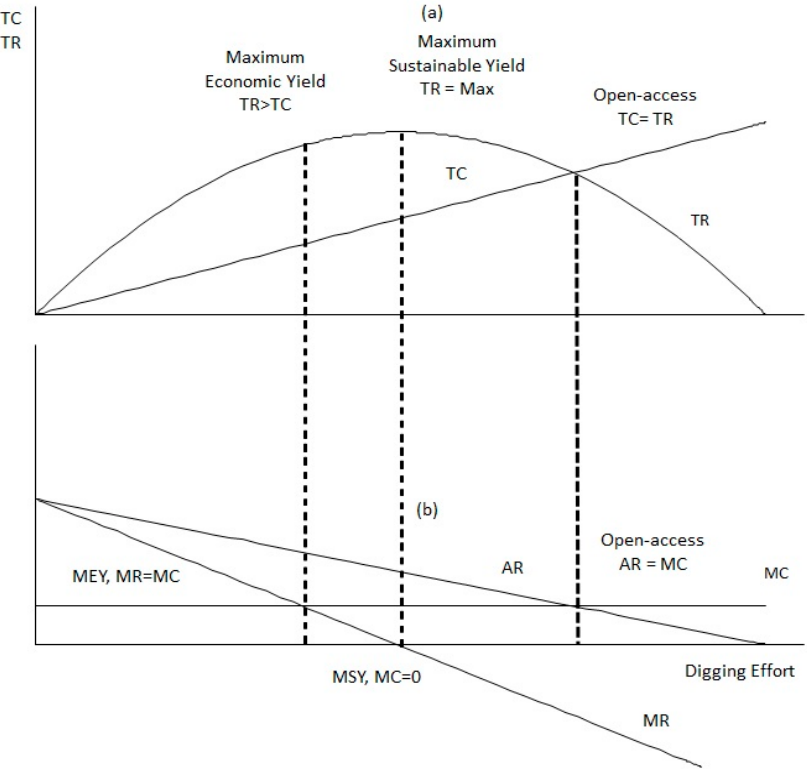
Figure 9. Digging Effort and Economic-Environmental Implications of baitworm fishing in the Aveiro Lagoon. Subfigure ( a ) presents the performance of Total Costs and Revenues under the Open-Access, Marginal Sustainable Yield (MSY) and Marginal Economic Yield (MEY) scenarios while subfigure ( b ) shows the trends of Marginal Revenues and Costs and Average Revenues under the same scenarios. Source: Flaaten [53] modified with permission from Ola Flaaten, Fisheries Economics and Management ; published by Bookboon, 2016. Note: TC = Total Costs; TR = Total Revenues; MEY = Maximum Economic Yield; MSY = Maximum Sustainable Yield; MC = Marginal Costs; MR = Marginal Revenues, AR= Average Revenues.